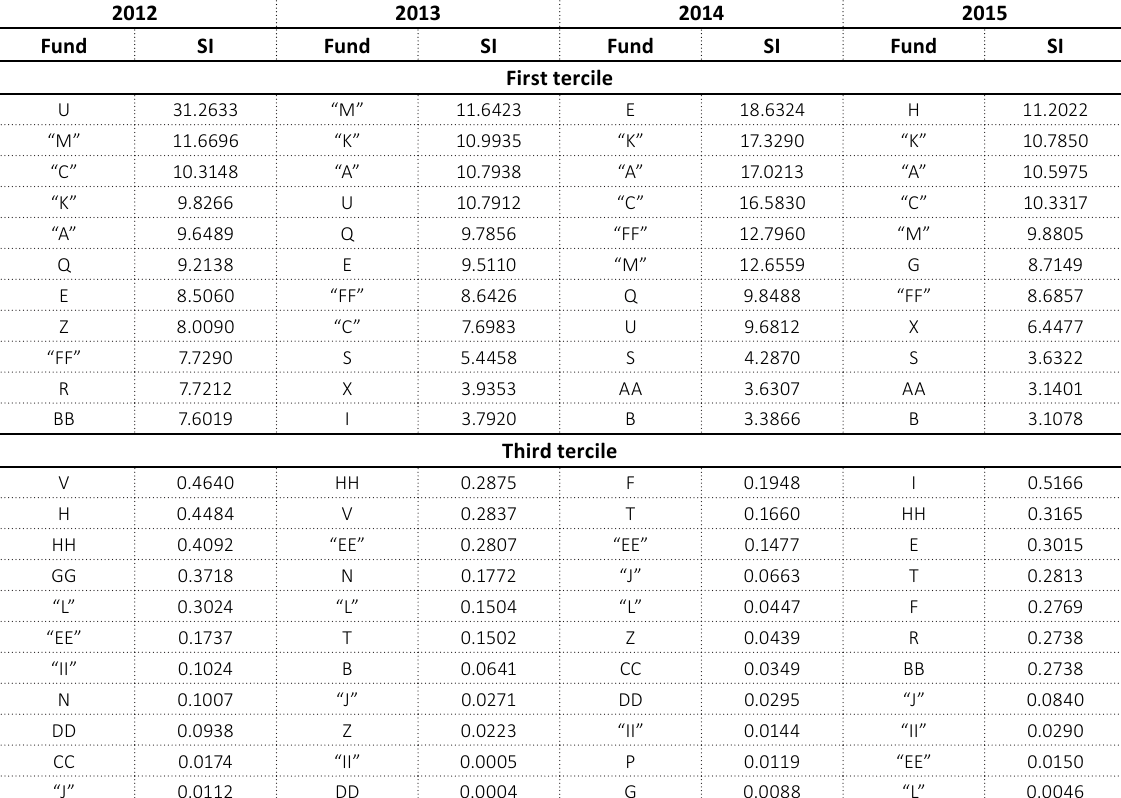
Source: Provided by the authors from the research